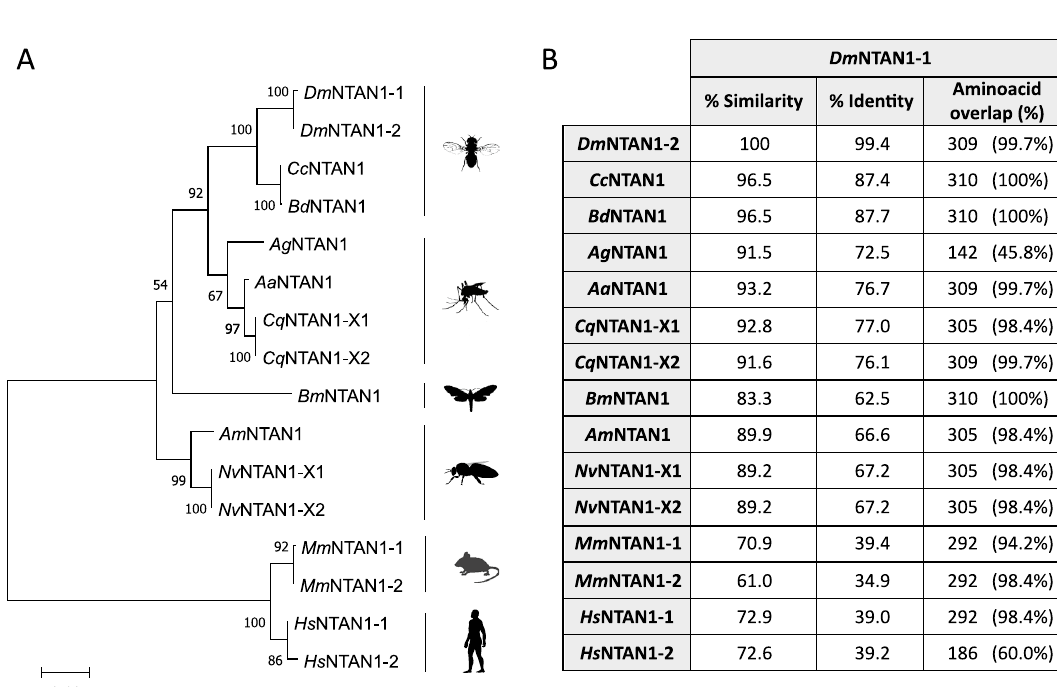
Figure 2. Comparative analysis of the aminoacid sequences of the NTAN1 isoforms of various insect and non-insect species. ( A ) Neighbor Joining tree of insects and other mammalian species NTAN1 orthologs. Dm ( Drosophila melanogaster ), Cc ( Ceratitis capitata ), Bd ( Bactrocera dorsalis ) Ag ( Anopheles gambiae ), Aa ( Aedes aegypti ), Cq ( Culex quinquefasciatus ), Bm ( Bombyx mori ), Am ( Apis mellifera ), Nv ( Nasonia vitripennis ), Mm ( Mus musculus ) and Hm ( Homo sapiens ). The tree was built with MEGA11. Bootstrap support (1000 replicates) is indicated. The scale bar units show aminoacid substitutions per site. ( B ) Comparison of sequence similarity and identity between the Dm NTAN1-1 isoform and the other isoforms of the different species studied with the LALIGN/PLALIGN